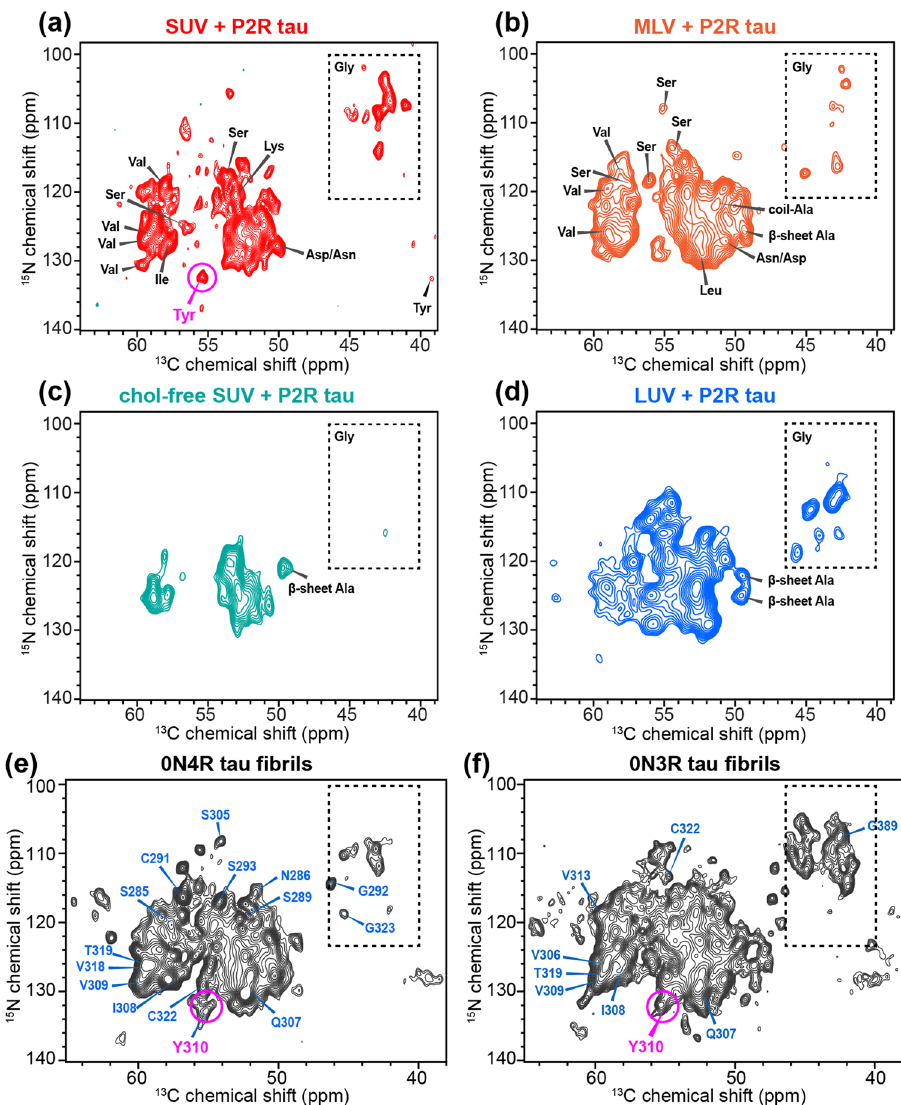
Fig. 4 2D NCA correlation spectra indicate that equilibrated SUV-bound tau has an amyloid- fi bril like structure, which differs from MLV- and LUV- bound tau. a Spectrum of SUV-bound P2R tau. The Tyr/Phe peak that matches the Y310 peak in heparin- fi brillized tau is circled. A weak C β chemical shift is also observed. b Spectrum of MLV-bound P2R tau, showing broader linewidths, no Tyr/Phe peak, and few Gly peaks compared to the SUV spectrum. c Spectrum of Cholesterol-free SUV-bound P2R tau, showing broader linewidths, no Gly nor Tyr/Phe signals compared to the SUV sample. But a β -sheet Ala signal is observed. d Spectrum of LUV-bound P2R tau, also showing β -sheet Ala signals. e Spectrum of heparin-induced 0N4R tau fi brils 39 . Some of the sequentially assigned peaks are given. f Spectrum of heparin-induced 0N3R tau fi brils 41 , showing some of the sequential